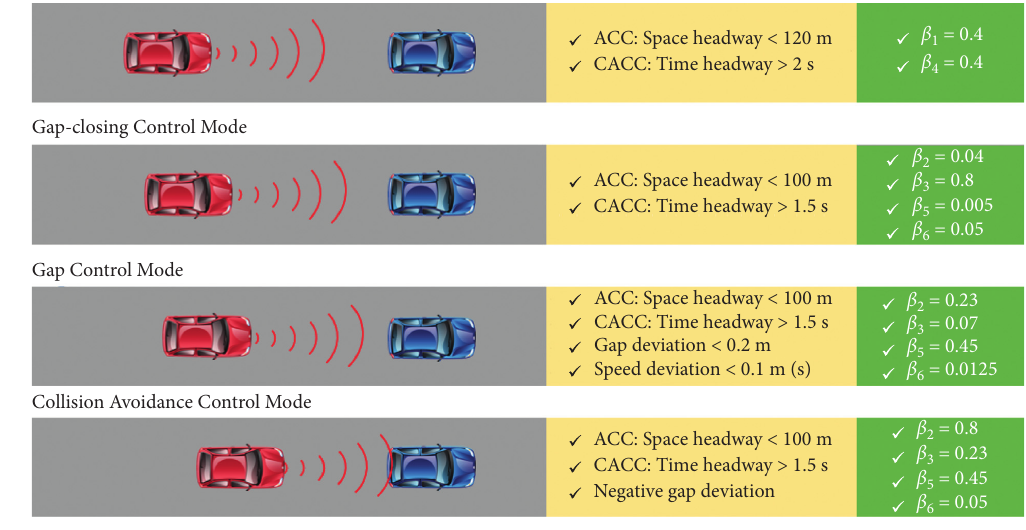
Figure 2: Modes of CACC car-following